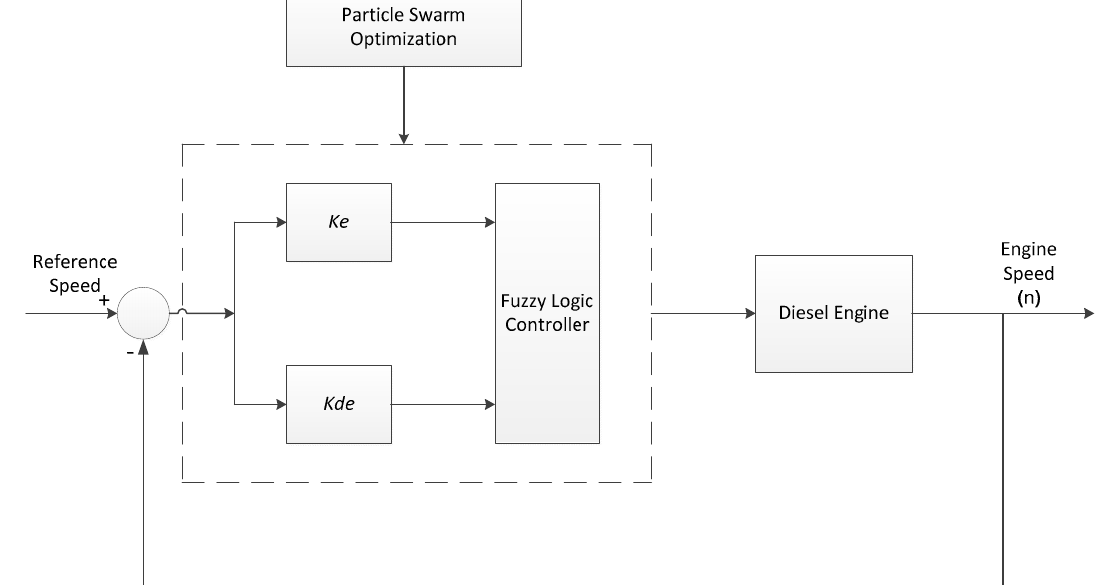
Figure 11. Block diagram of fuzzy logic control with particle swarm optimization.